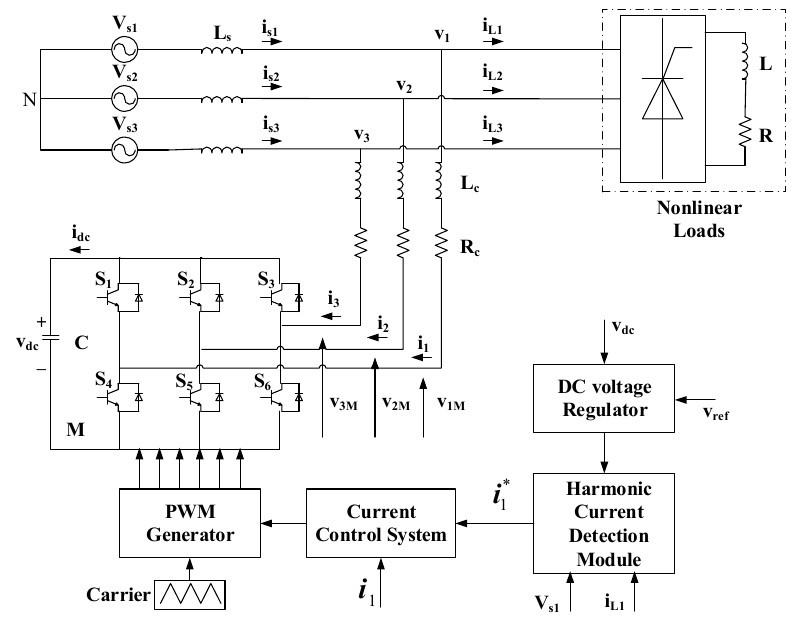
Figure 1. Block diagram of the main circuit of an APF .